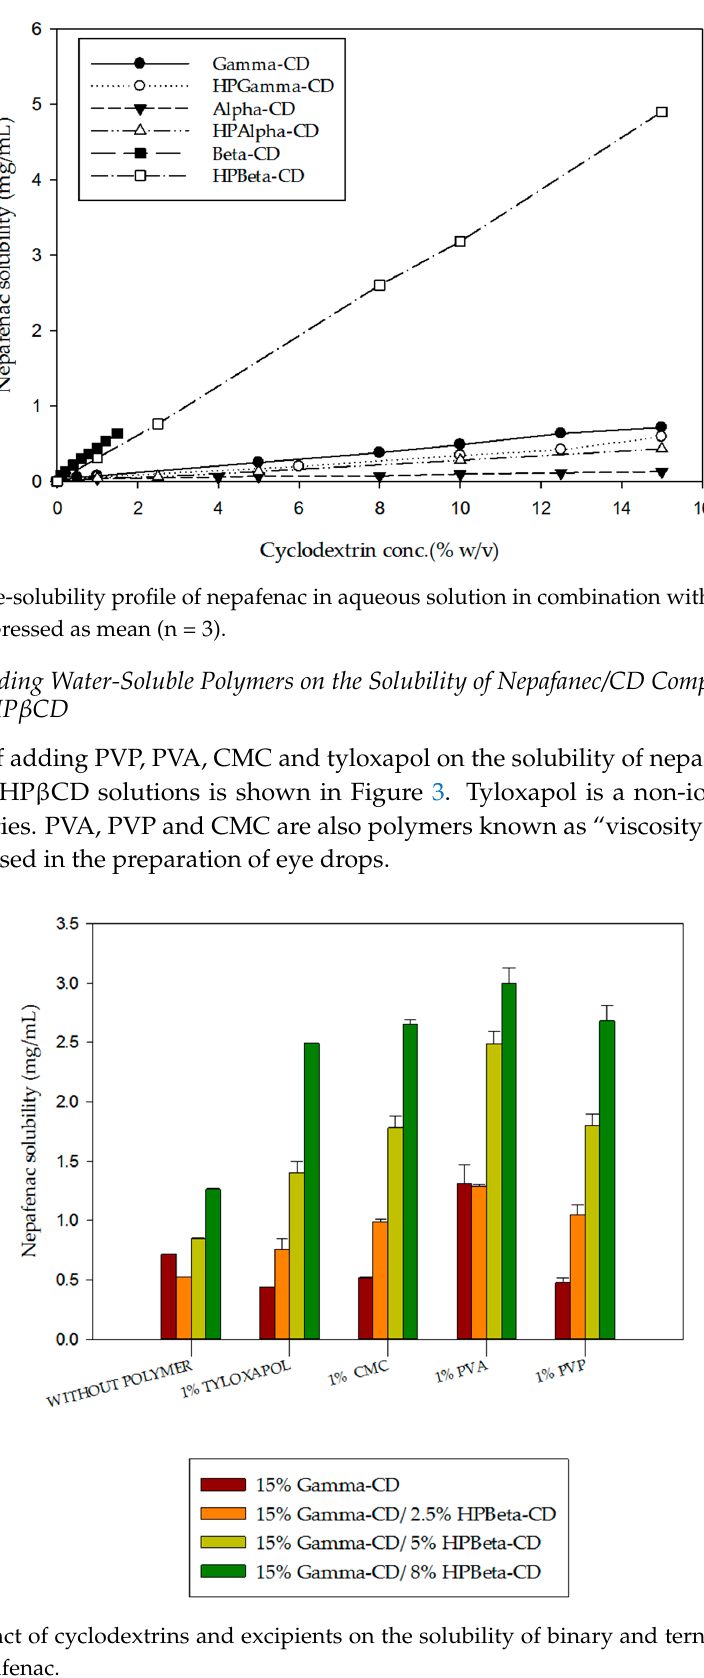
including nepafenac. including